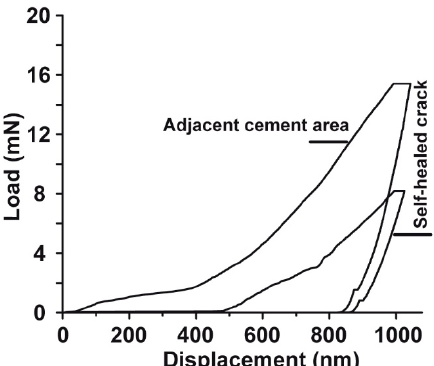
Figure 11. Hardness measurement within the self-healed crack area and the adjacent non-cracked area